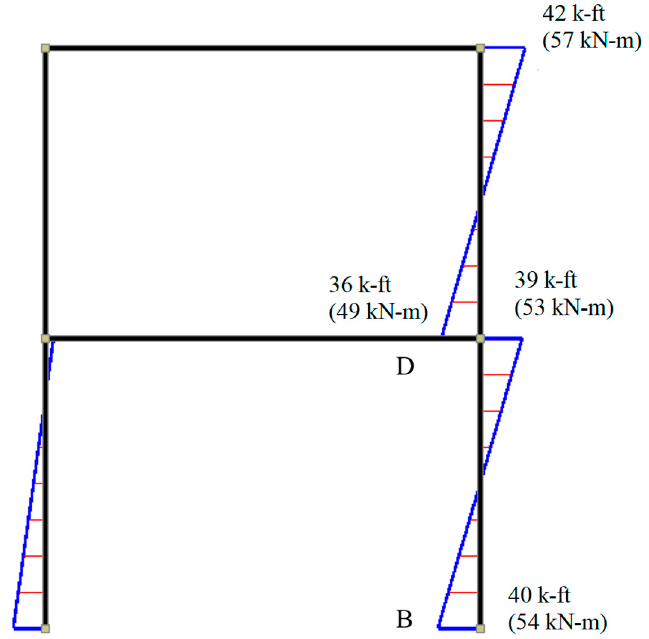
Figure 4. Factored design moment M uc for columns for combined gravity and lateral seismic forces.